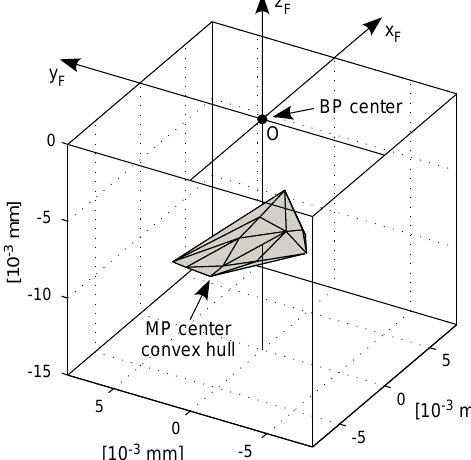
Figure 5. Displacement error s of the MP mapped in the joint space.